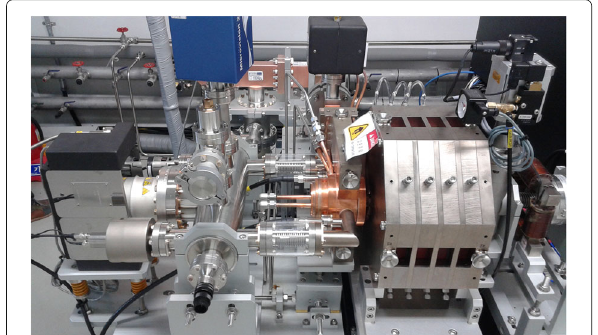
Fig. 3 The laser heater of PAL-XFEL. Four dipole magnets are shown before and after the undulator (yellow